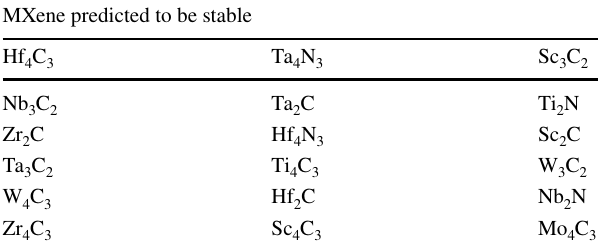
Table 1 18 kinds of MXenes with high synthesis possibility [20] MXene predicted to be stable